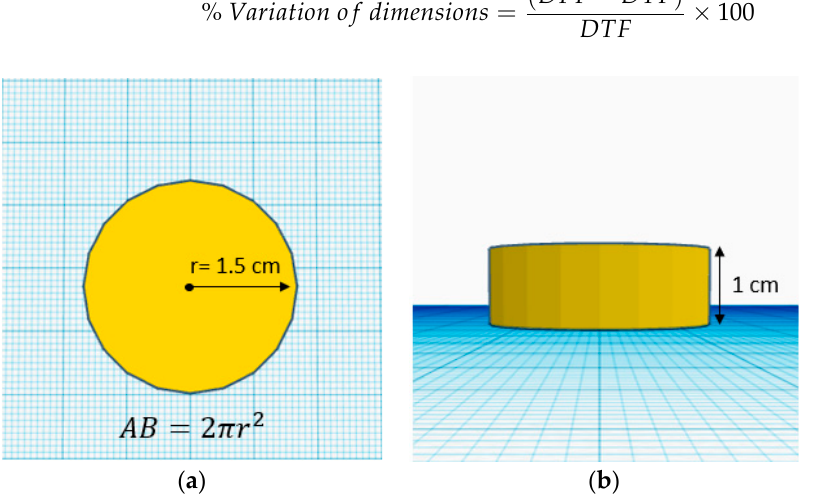
Figure 6. ( a ) Cylinder base area; ( b ) Cylinder